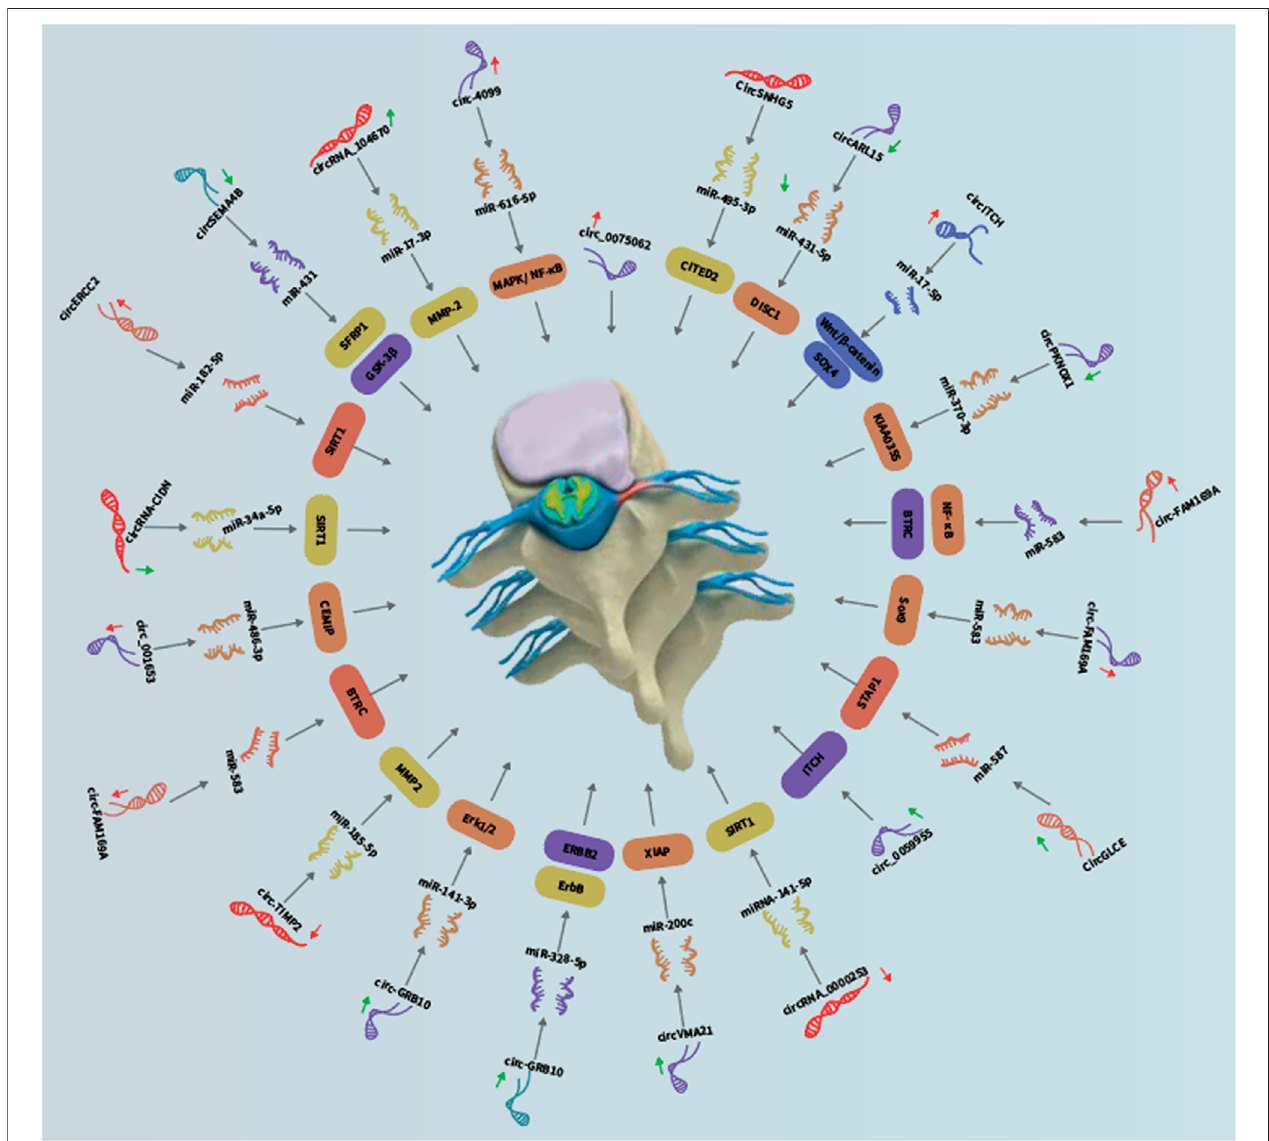
FIGURE 4 | Crucial roles of circRNAs in IDD